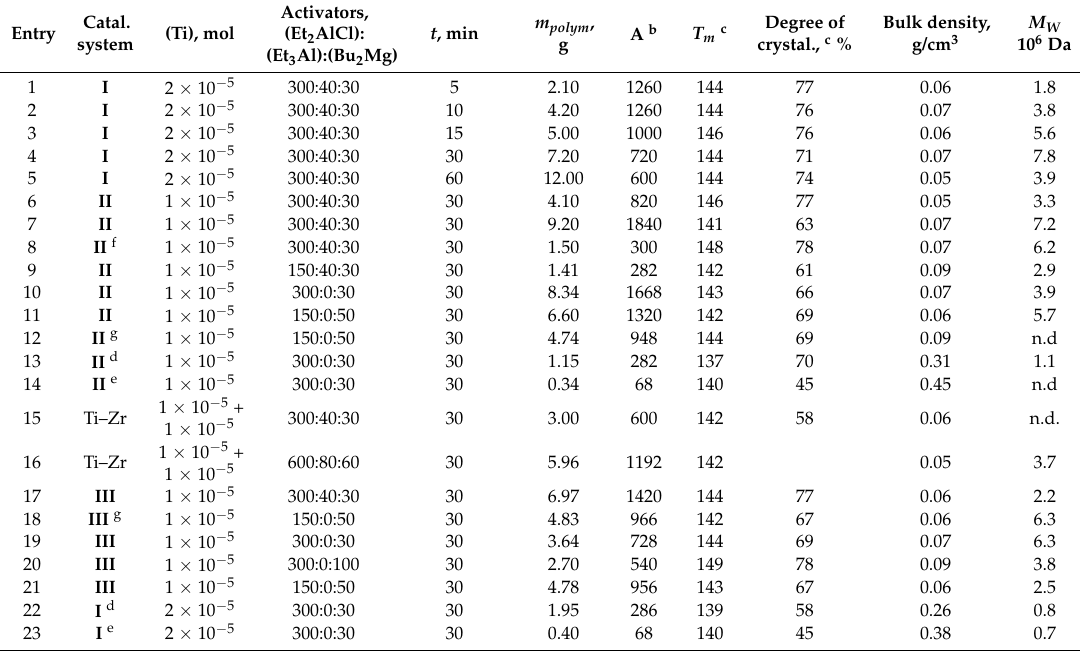
Table 1. Ethylene polymerization results using catalytic systems I – III a